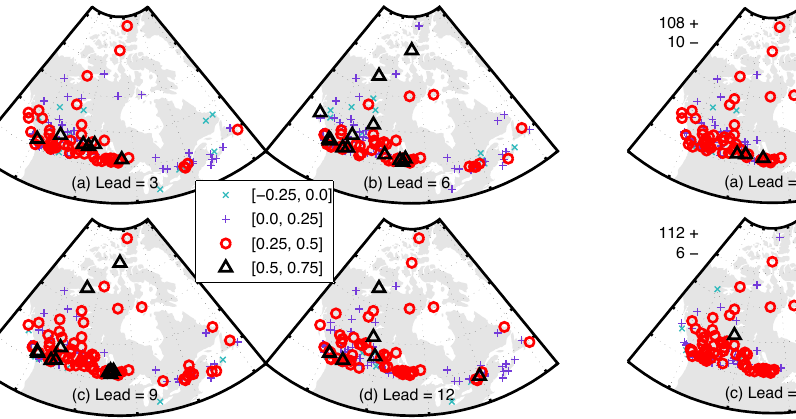
Fig. 8. Spatial distribution of the forecast correlation skills of the SVR-R model at individual stations over Canada at lead times of (a) 3, (b) 6, (c) 9 and (d) 12months.